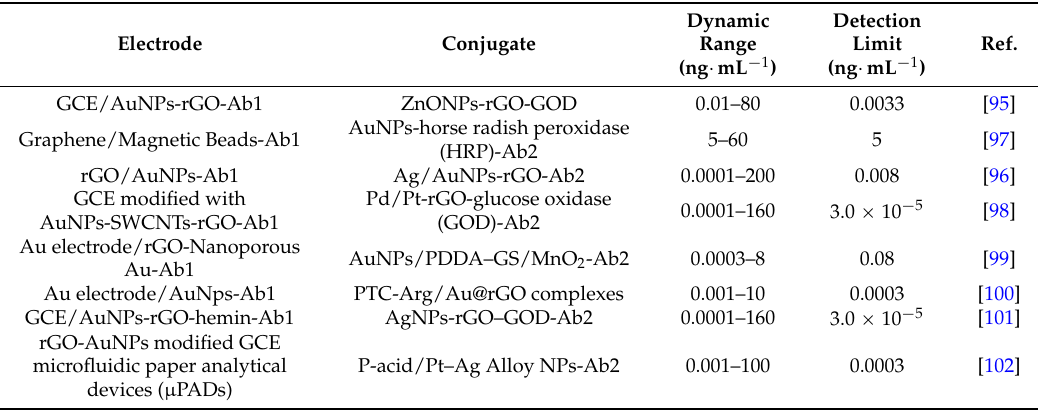
Table 1. Sandwich-type graphene-based biosensor performance for the detection of carcinoembryonic antigen